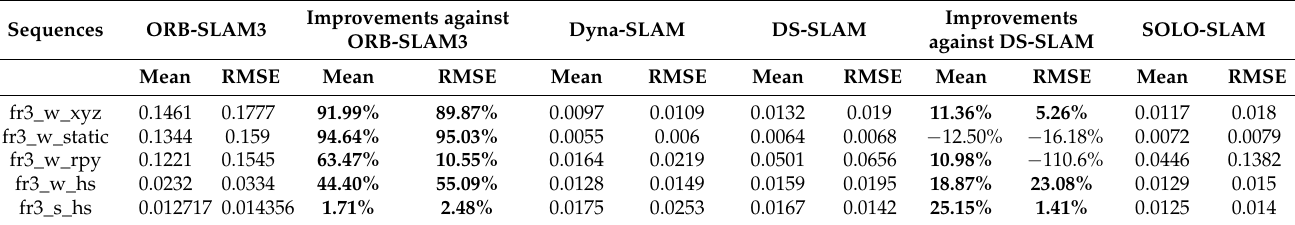
Table 4. Experimental results of rotational relative trajectory